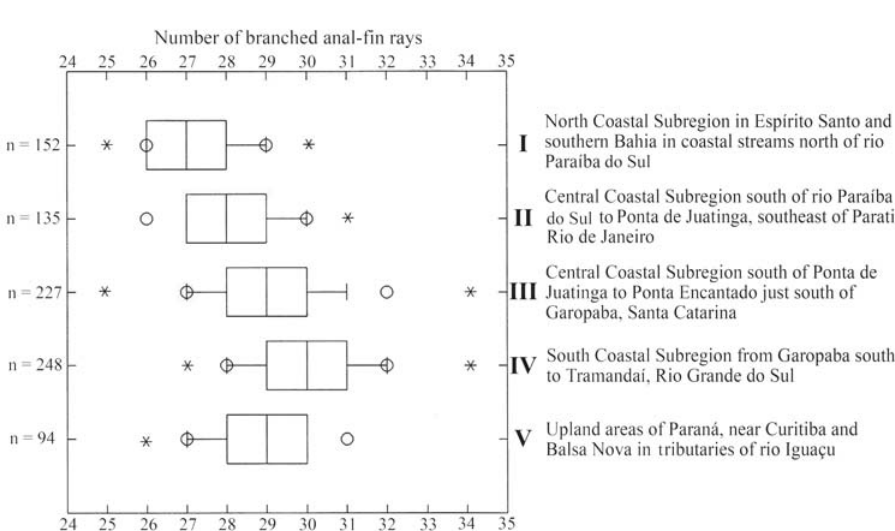
Fig. 89. Comparative plots of the number of branched anal-fin rays for population samples of Mimagoniates microlepis within range of species expressed by Tukey box plots based on